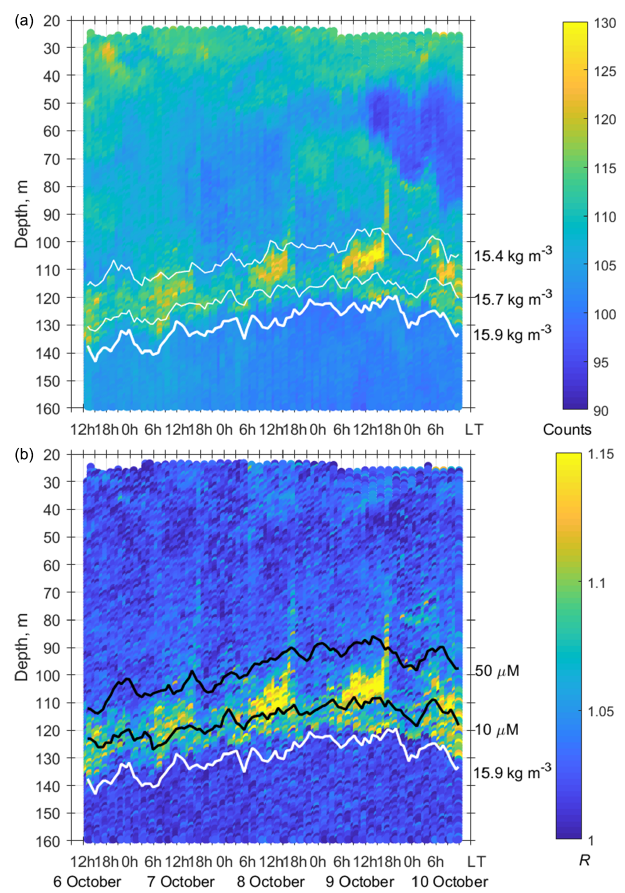
Figure 7. (a) The time–depth scatterplot of the Aquadopp horizontal-beam echo (A 1 + A 2 )/ 2 on 6–10 October 2016. (b) The time–depth graph of the Aquadopp directional acoustic backscatter ratio R . The isopycnals and isooxylines are superimposed near the